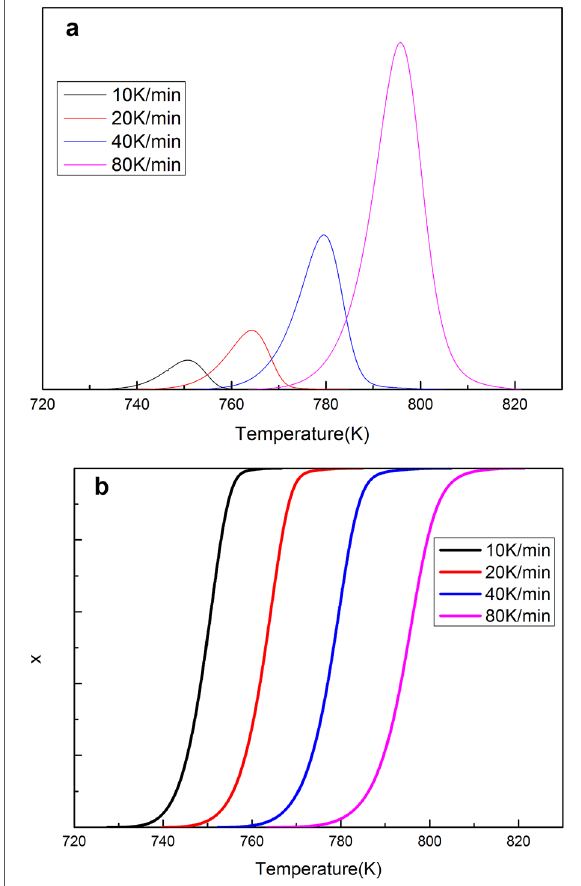
Figure 5 Non-isothermal crystallization procedures of Zr 63 Fe 2.5 Cu 23 Al 11.5 BMG under different heating rates: a plots of the crystallization peaks; b plots of crystallization volume fraction x versus temperature